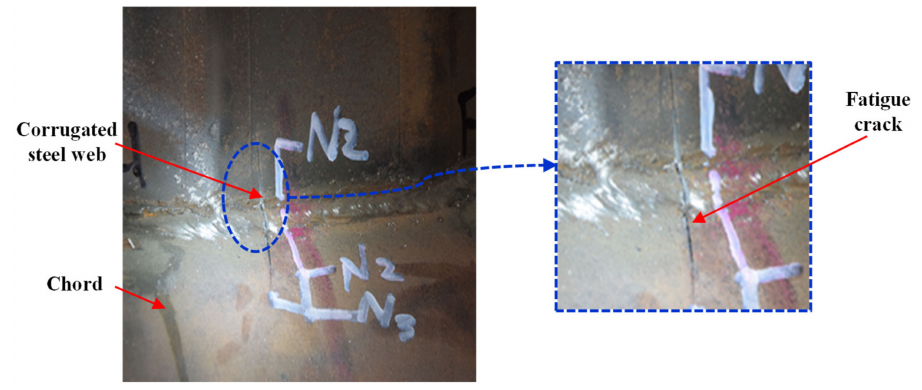
Figure 15. Fatigue failure mode.